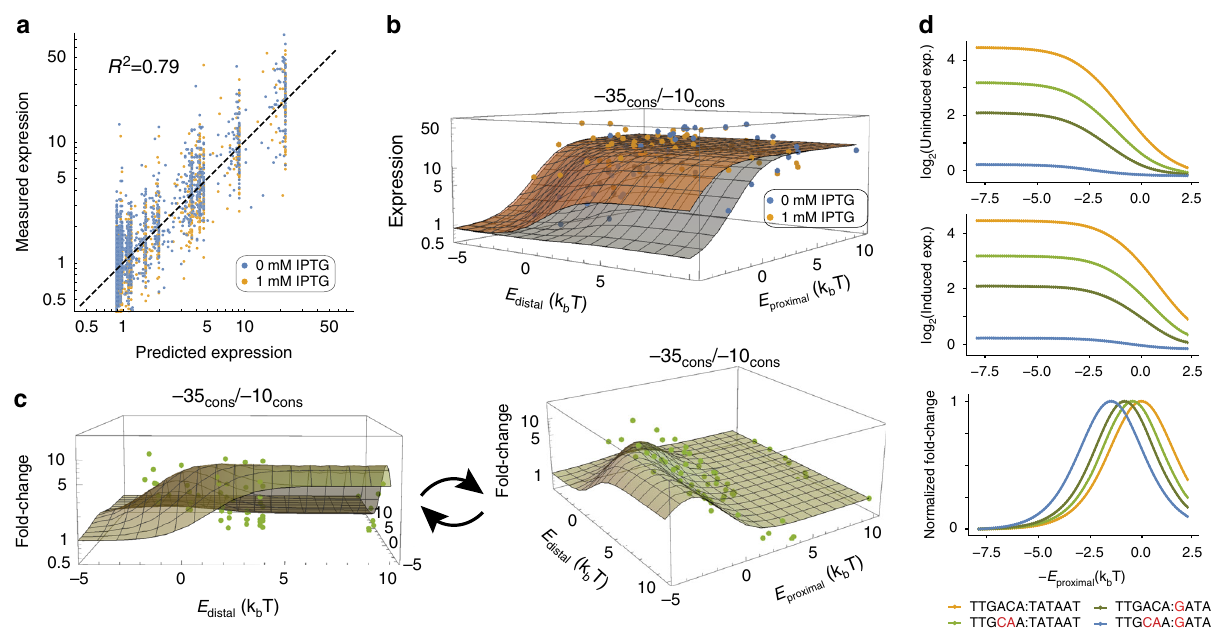
Fig. 3 Thermodynamic modeling of lacUV5 promoter architecture. a Correlation between actual lacUV5 variant expression and expression fi t by our thermodynamic model ( r 2 = 0.79, P < 2.2 × 10 − 16 , two-sided Student ’ s t test). b Induced and uninduced gene expression across the distal and proximal site binding energy parameter space. c Fold change (FC) in gene expression as a function of distal and proximal binding site energies. In panels b and c , each dot represents experimental data whereas the grid lines denote the inferred expression of a promoter with the proximal (E proximal ) and distal (E distal ) LacI binding energies shown. d As promoter strength decreases, optimal induction responses are achieved at lower proximal LacI binding site energies. Promoter binding sites are shown as − 35 sequence: − 10 sequence. These trends are shown in the context of an O 1 distal site (E distal = − 0.23). Source data are available in the Source Data fi